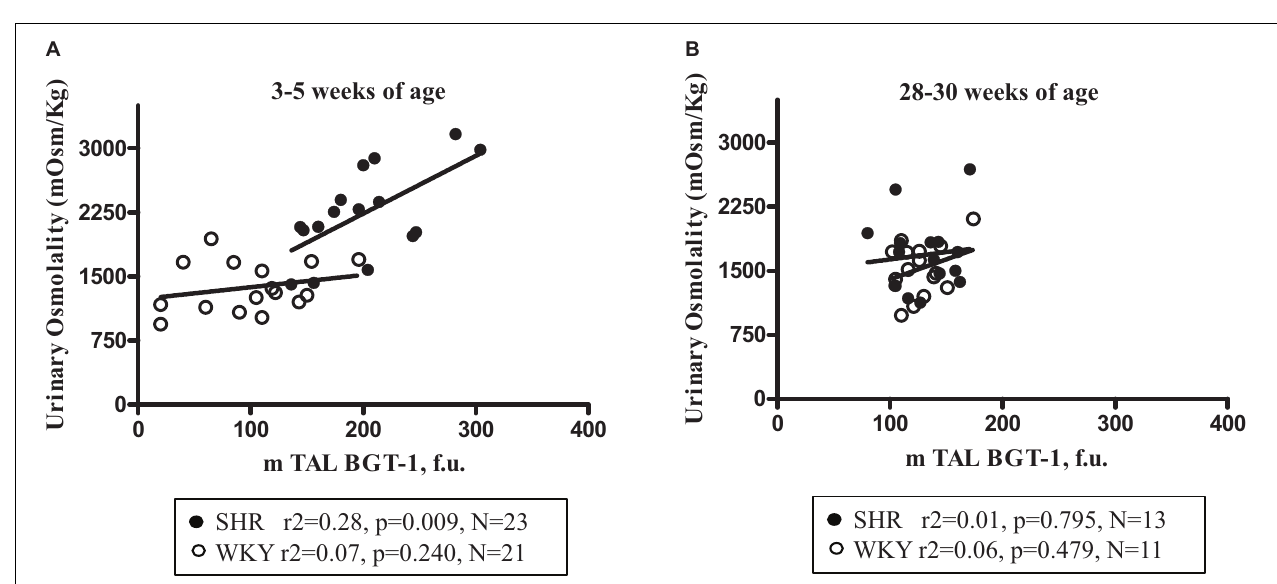
FIGURE 4 | Kidney tubule BGT-1 immunostaining in prehypertensive young female SHR (A,C) vs. age-matched WKY (B,D) and in old (28–30 weeks of age) hypertensive female SHR (E,G) vs. age-matched WKY (F,H) . Indirect immunoperoxidase in paraffin sections (A,B,E,F) and indirect immunofluorescence reaction in cryosections (C,D,F,H) in young and old female SHR and WKY. Units: 200 µ m (A,B,E,F) ; 100 µ m (C,D,G,H) .